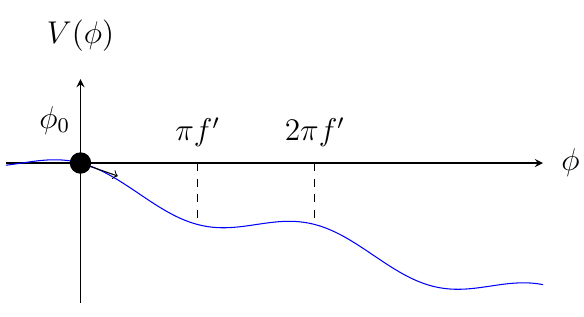
Figure 4 . Sketch of the relaxion potential assuming a coincidence of scales that may avoid the requirement of initial large velocity. Here for convenience we set V ( (cid:30) 0 ) = 0 and (cid:30) 0 =